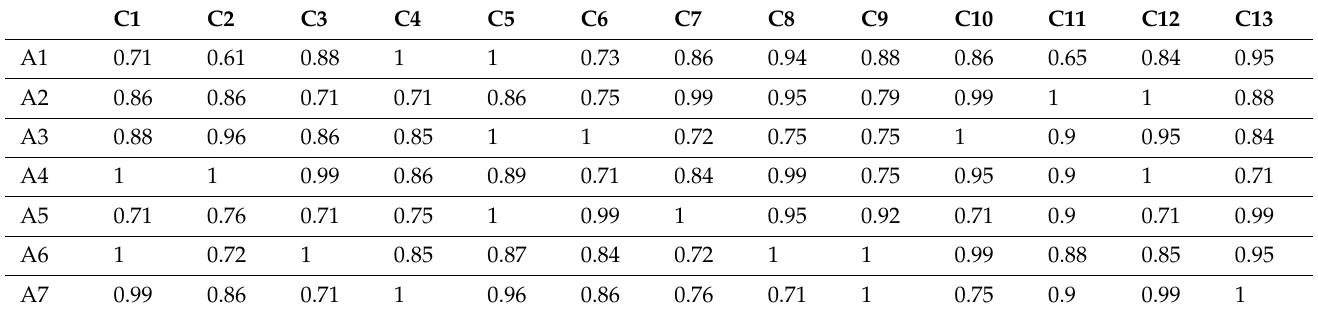
Table 9. Dimensionless decision matrix.